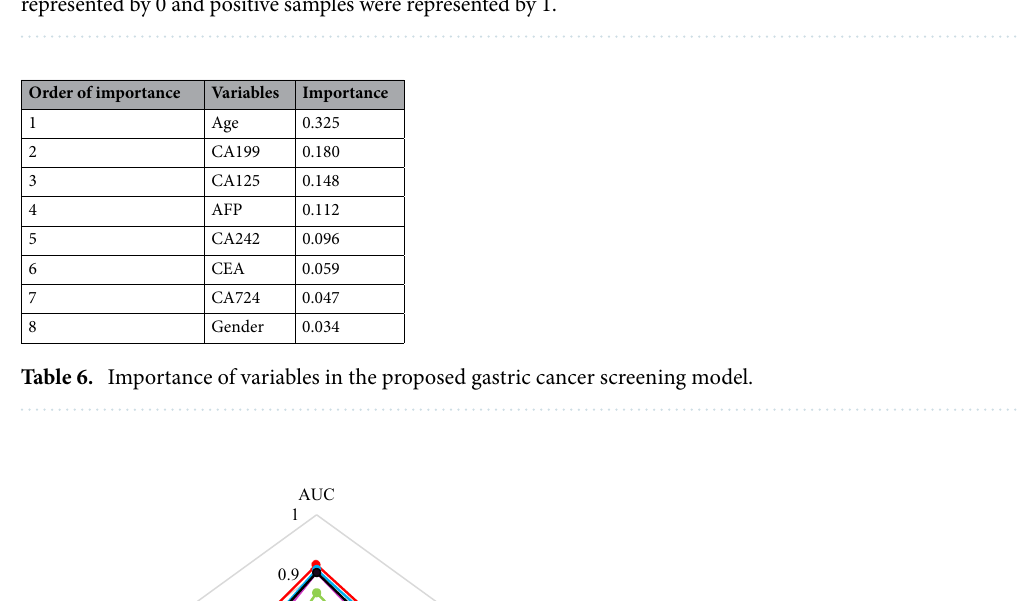
Figure 6. Confusion matrix of the classification model when the threshold was 0.5. Negative samples were represented by 0 and positive samples were represented by 1.